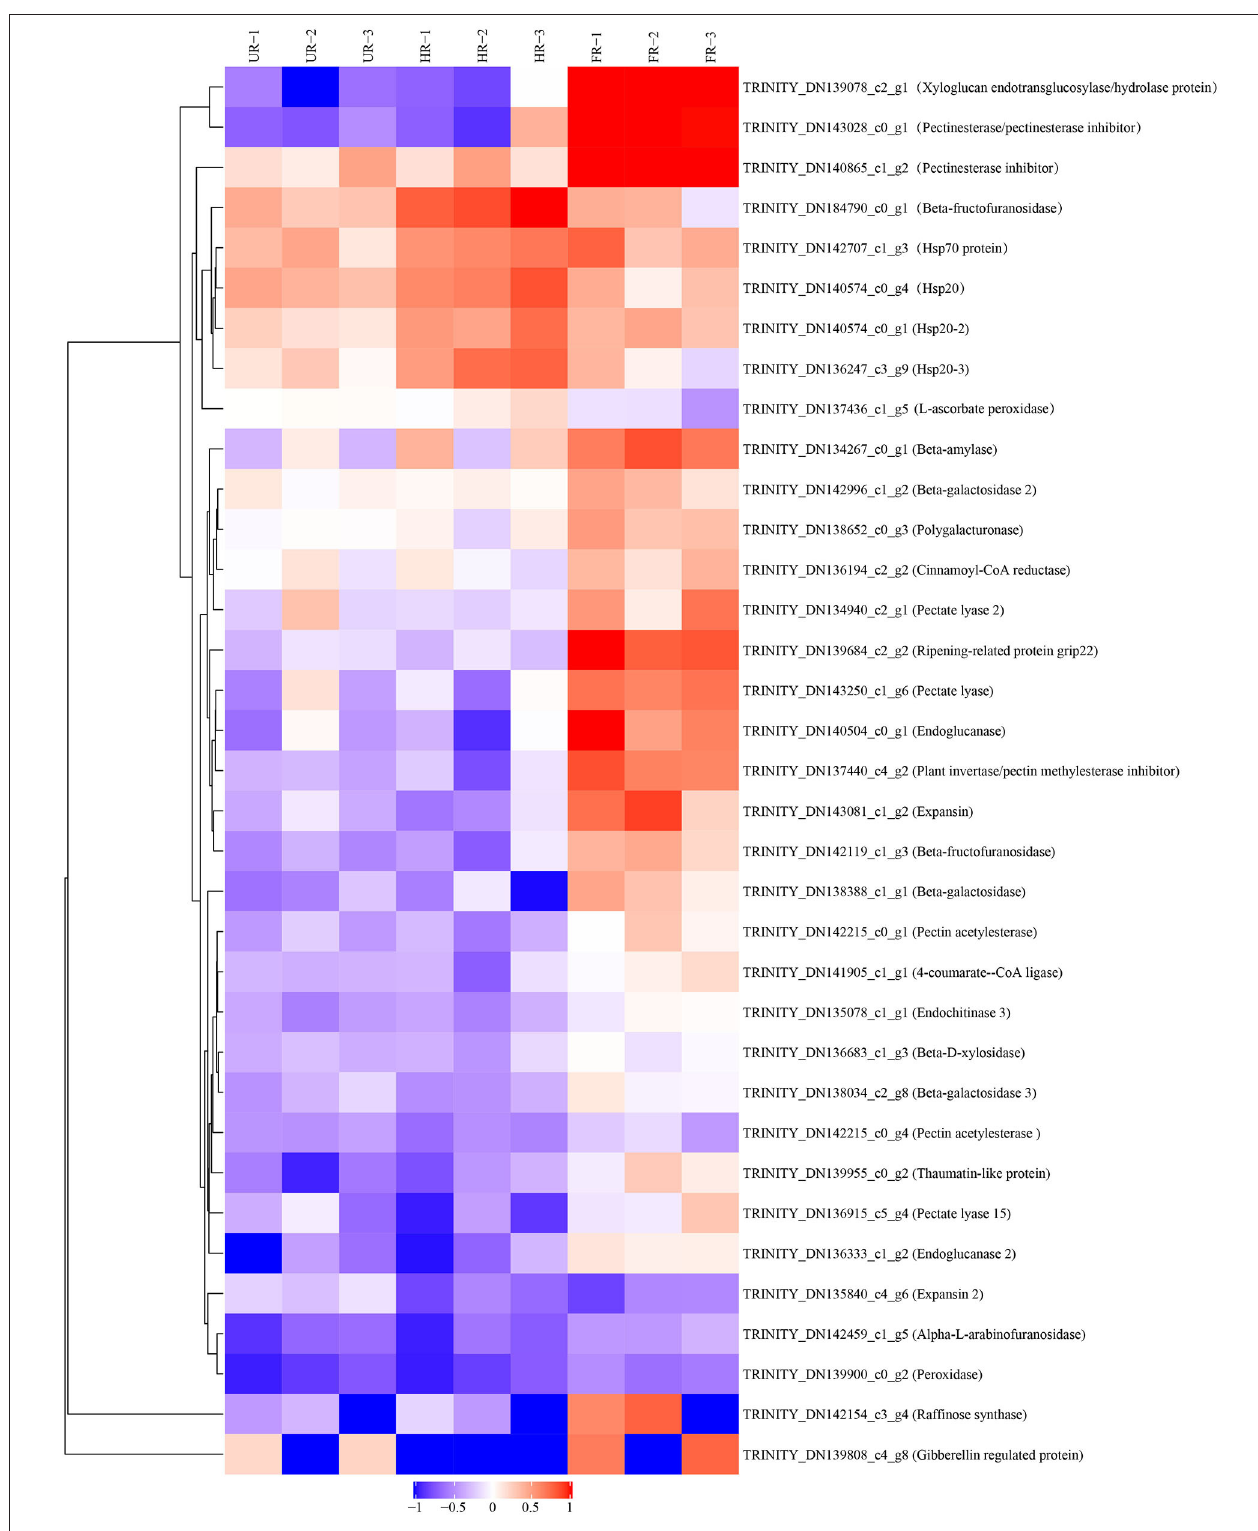
FIGURE 6 | Heatmap analysis of DAPs in UR, HR, and FR (three biological replicates) based on proteomic data, which are associated with cell wall metabolic, plant hormones, and stress response processes.